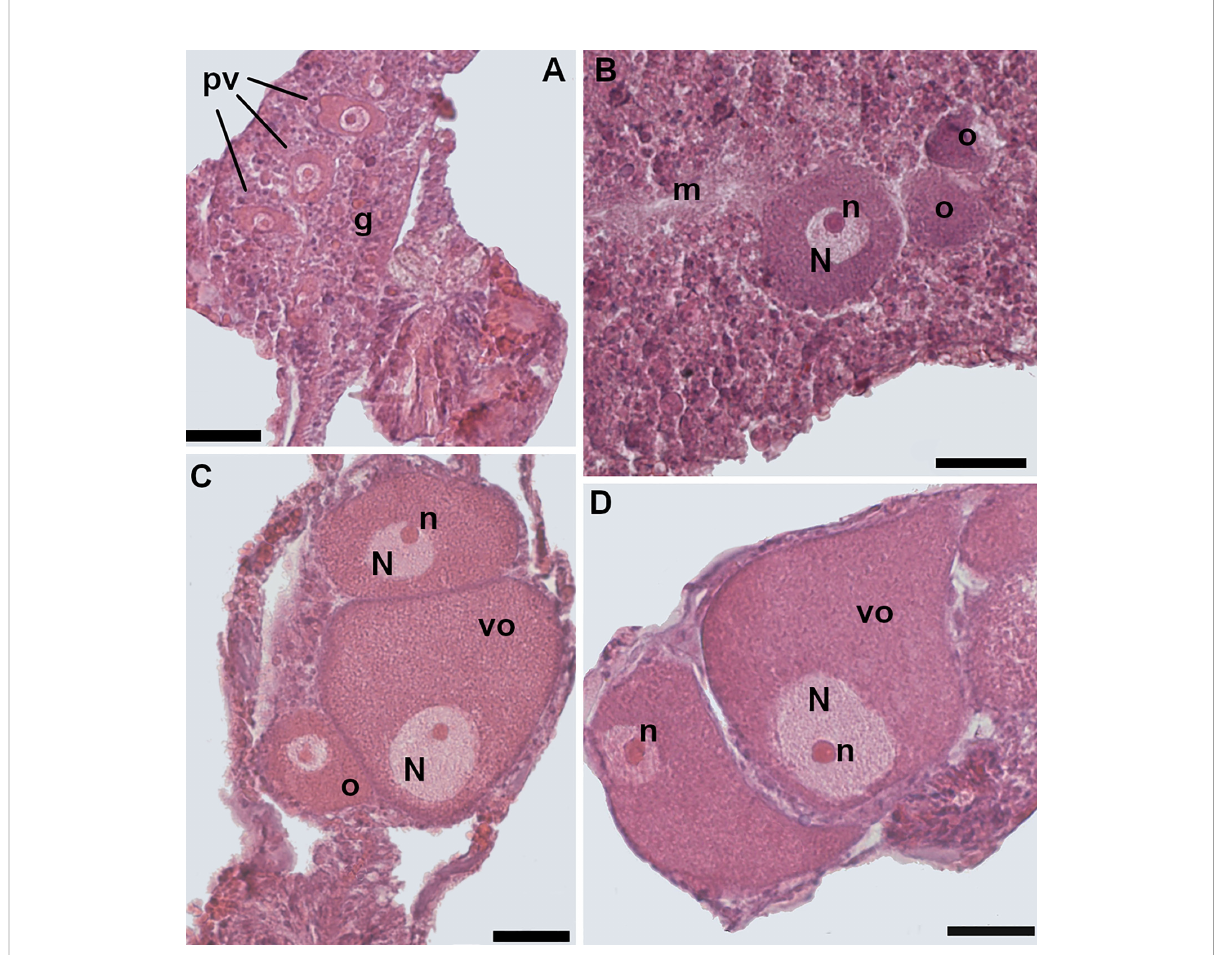
FIGURE 5 Oogenesis. (A) Early stage: three previtellogenic oocytes in the gastrodermis of the mesentery, characterized by a high nucleus/cytoplasm ratio. (B) Intermediate stage: vitellogenic oocyte located in the mesoglea. The spherical-shaped nucleus is still located in the central portion of the cell. The nucleus/cytoplasm ratio is reduced. (C) Late stage: the nucleus of the oocyte has started to migrate toward the cell periphery. Note two smaller vitellogenic oocytes in the same section. (D) Late stage: two mature oocytes, located in the mesentery; the nucleus/cytoplasm ratio is greatly reduced. [o, oocyte; m, mesoglea; N, nucleus; n, nucleolus; pv, previtellogenic oocyte; vo, vitellogenic oocyte; g, gastrodermis]. Scale bars are 25 m